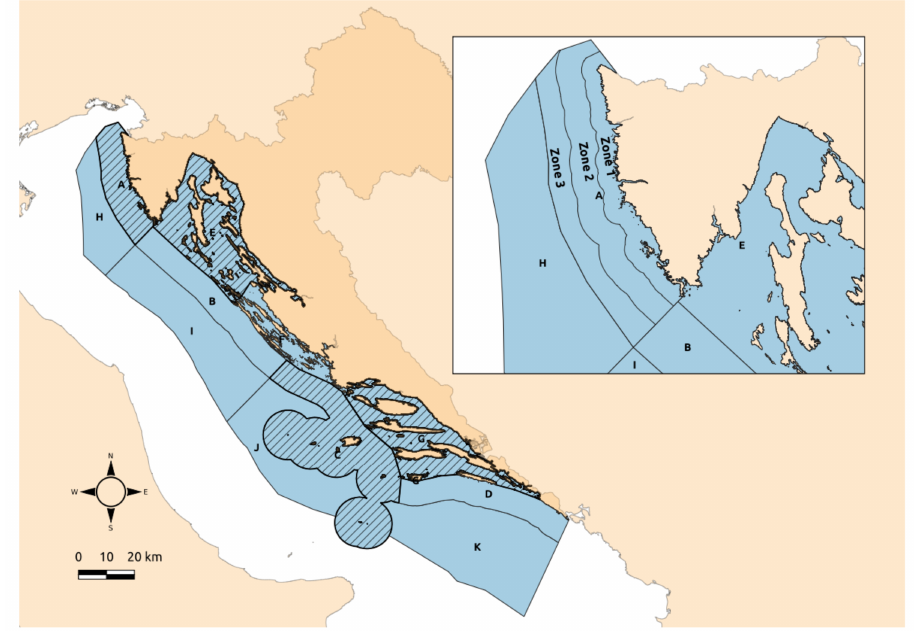
Figure 1. Sampling area of the European lobster, Homarus gammarus , in the Eastern Adriatic Sea (fishing zones A, E, C, and G); fishing zone A is divided into subzones according to distance from the coast (zones 1, 2, and